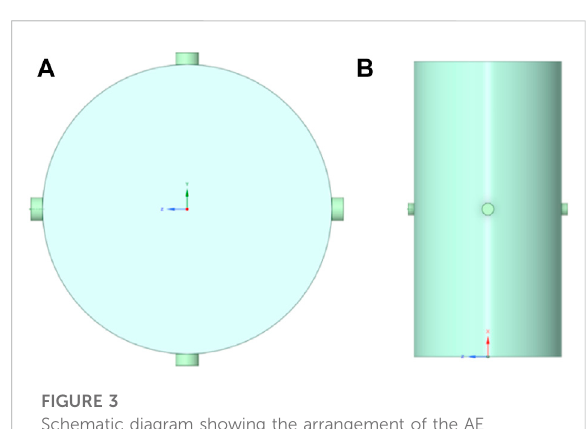
FIGURE 3 Schematic diagram showing the arrangement of the AE probes: (A) top view, and (B) front